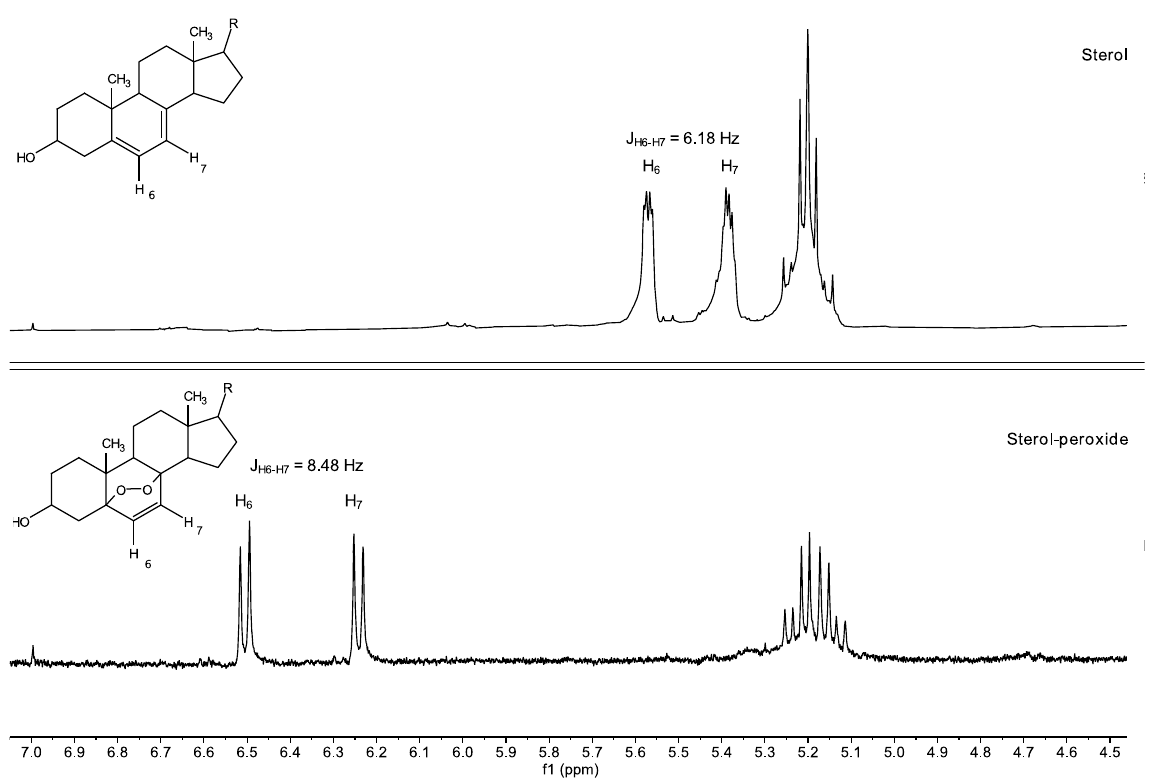
Figure 9. Structures of the sterols and their cyclic peroxides.